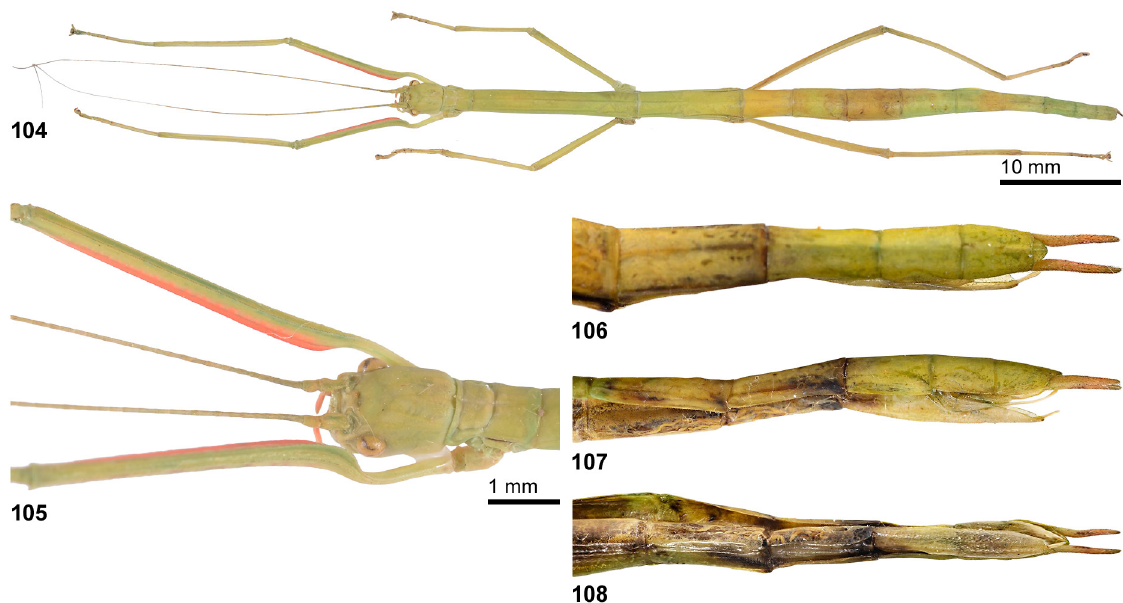
Figs 104–108. Phantasca ruboligata sp. nov. Paratype, ♀. 104 . Habitus, dorsal view. 105 . Head and pronotum, dorsal view. 106 . Apex of abdomen, dorsal view. 107 . Apex of abdomen, lateral view. 108 . Apex of abdomen, ventral